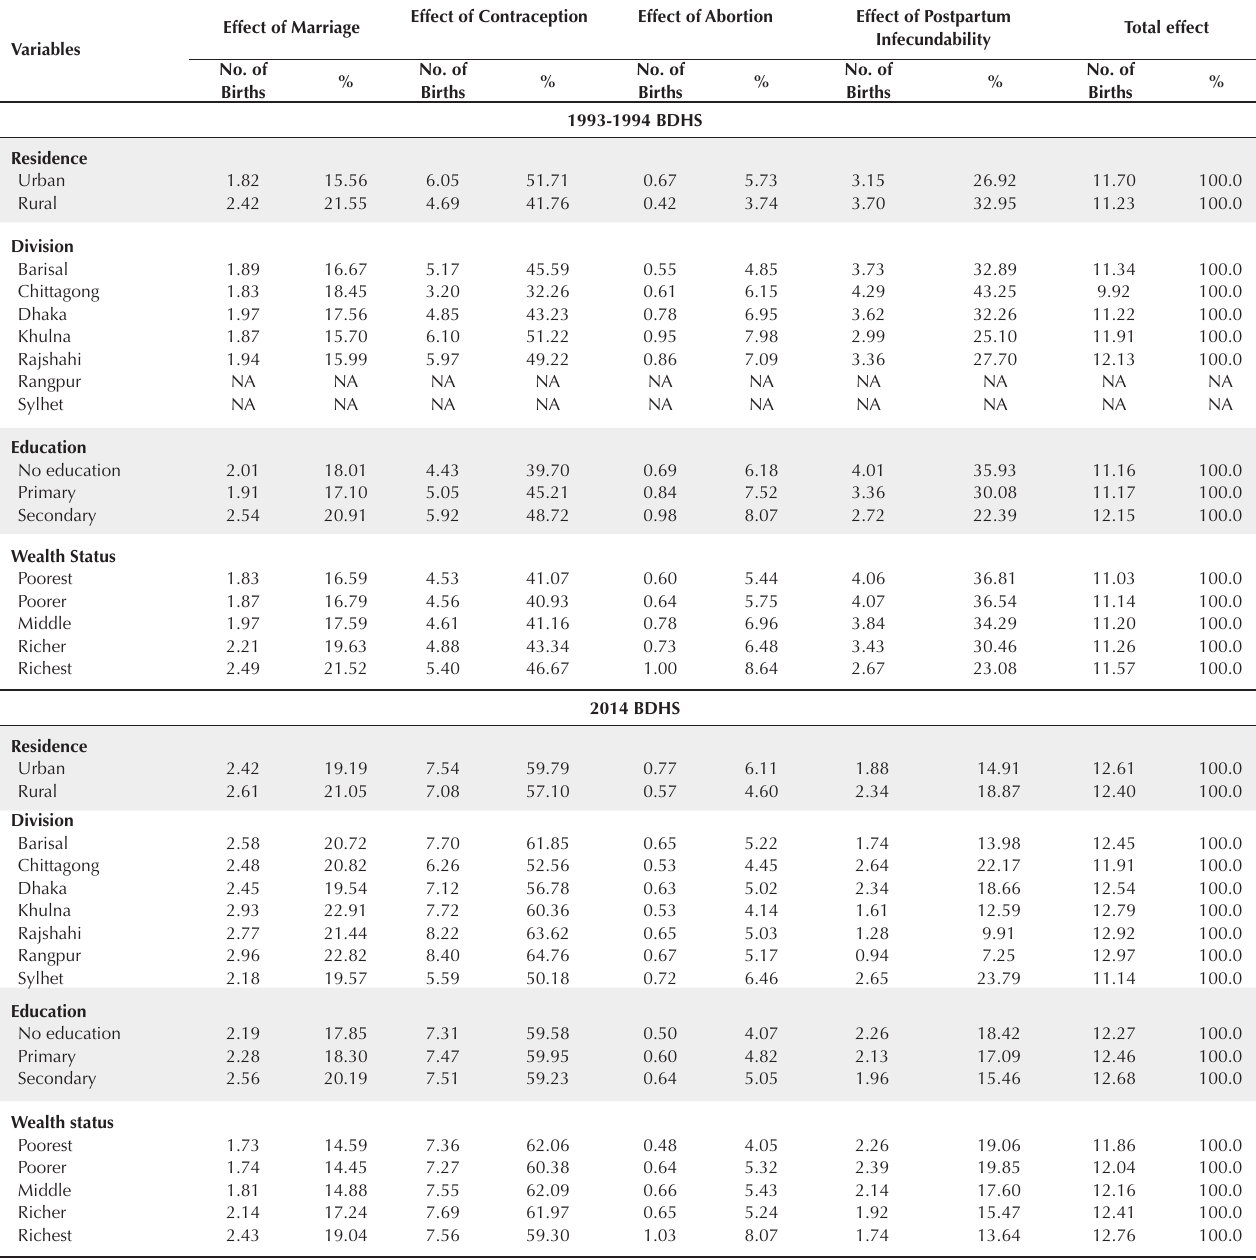
Table 5. Fertility Regulating Effects of Proximate Determinants of Fertility According to the Socioeconomic Characteristics in Bangladesh: 1993-1994 to 2014 BDHS Effect of Contraception Effect of Abortion Effect of Postpartum Effect of Marriage Variables